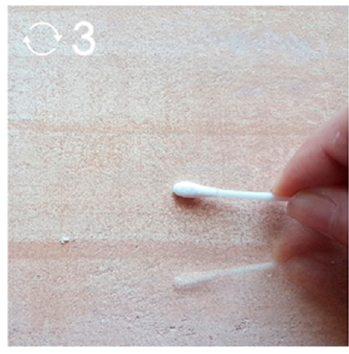
Figure 6. Abrasion test.